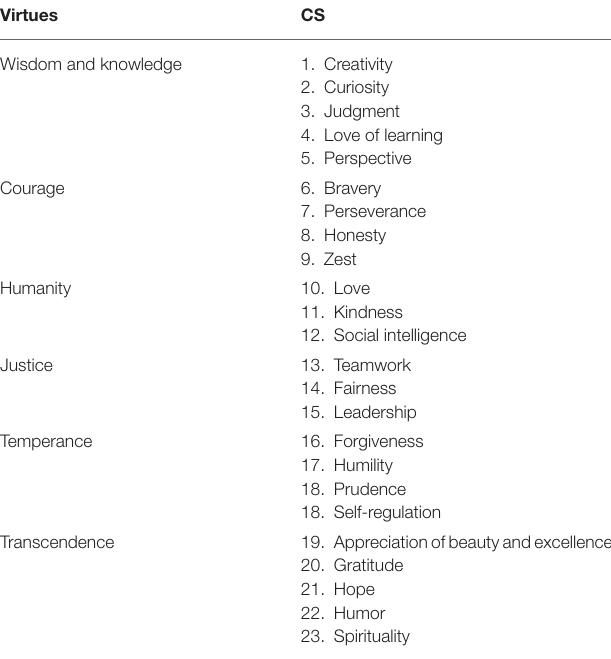
TABLE 1 | CS and virtues classification. Virtues